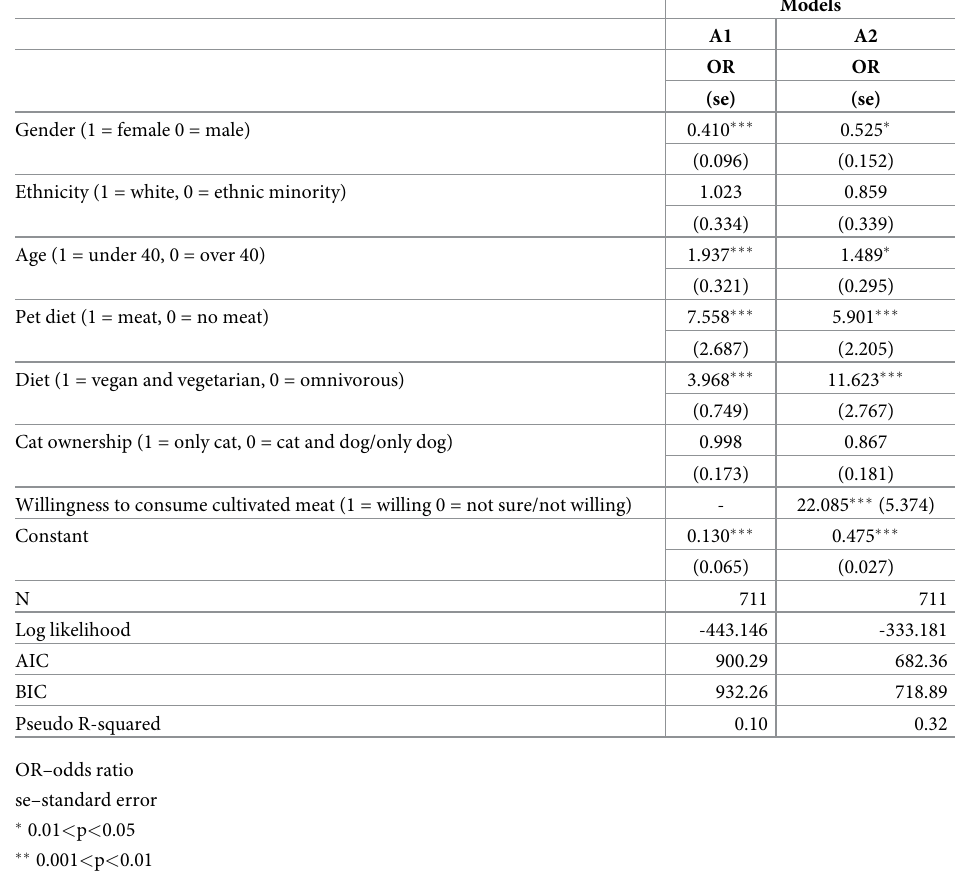
Table 9. Factors predicting the willingness to feed cultivated meat to